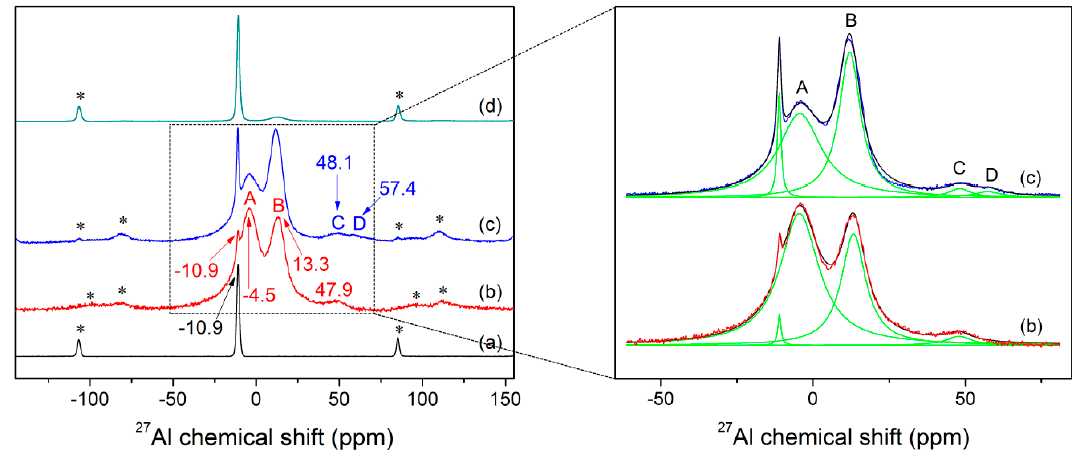
Figure 5. 27 Al MAS NMR spectra recorded at room temperature for the KAl(MoO 4 ) 2 samples prepared under different conditions: ( a ) slow cooling; ( b ) quenched at fast cooling; ( c ) quenched at a slow cooling rate; ( d ) quenched at fast cooling rate and then annealed at 723 K for 80 min, as well as the deconvolution of NMR spectra of fast and slow quenched samples (on the right part). The bands labelled with asterisks are related to spinning sidebands.